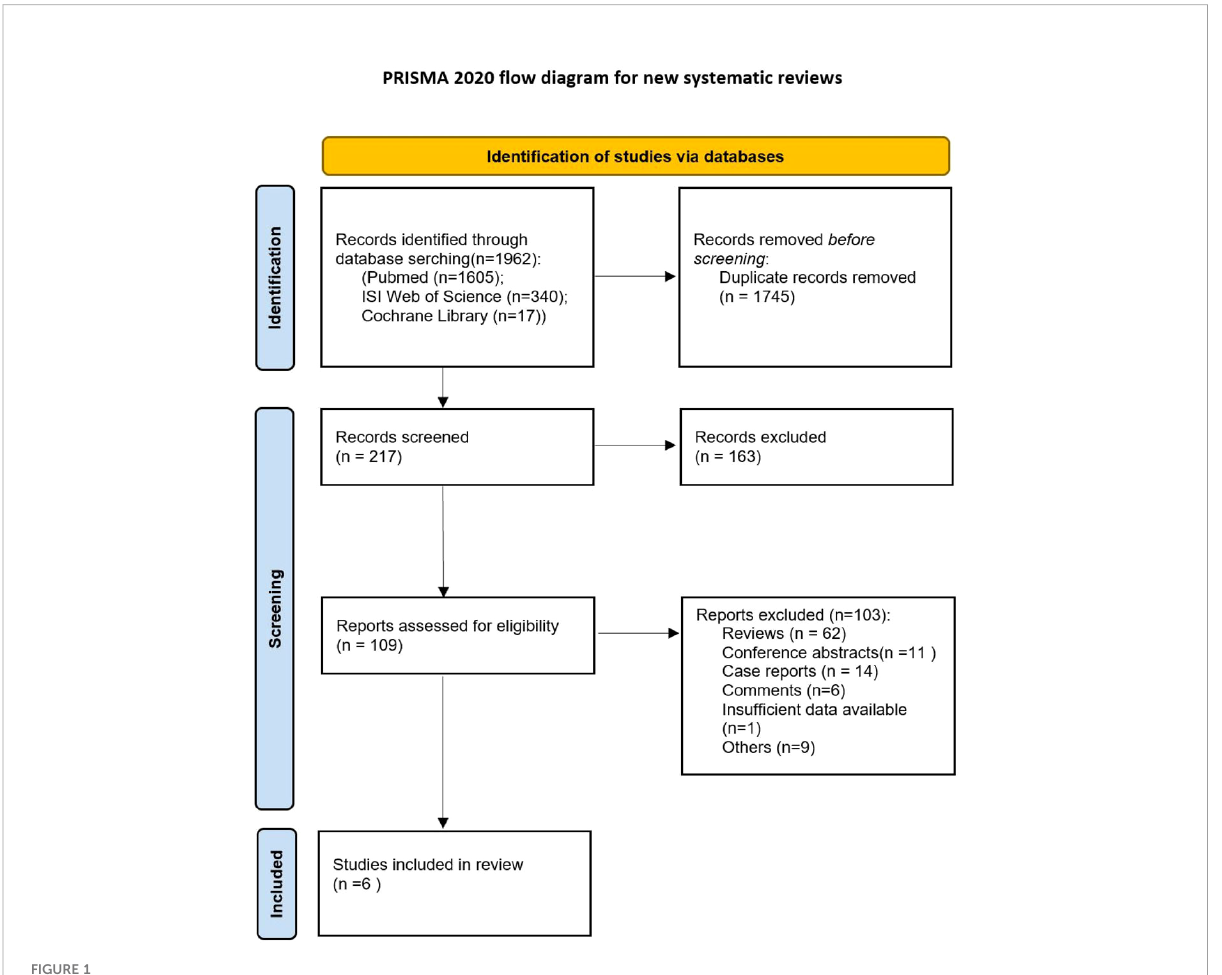
FIGURE 1 Flow diagram of included and excluded